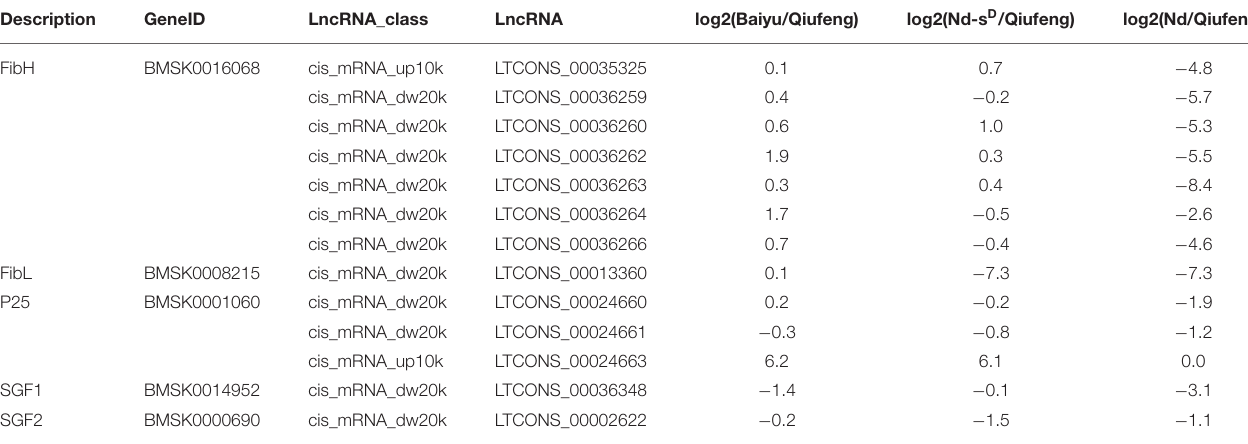
FibH, silk fibroin heavy chain gene; FibL, silk fibroin light chain gene; P25, fibroin P25; SGF1, silk gland factor 1; SGF2, silk gland factor